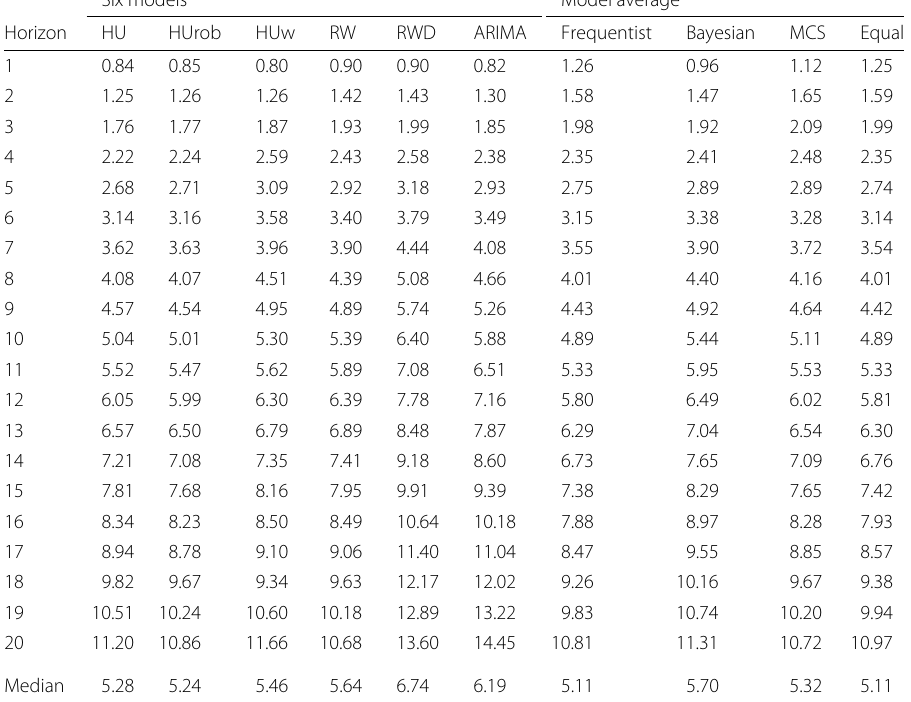
Table 3 Mean interval score ( × 100 ) for ASFRs for 1-year-ahead to 20-year-ahead interval forecasts by model/method and forecast horizon Six